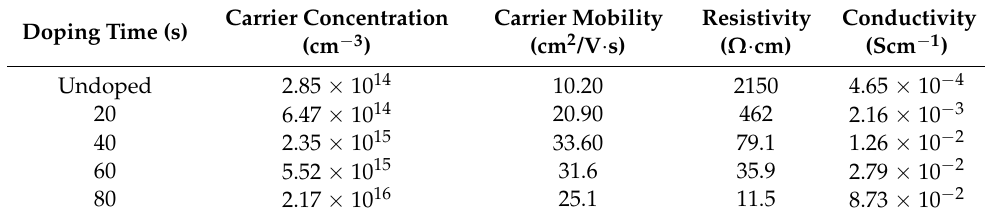
Table 3. Hall parameters of the Cr-doped NiO thin films.